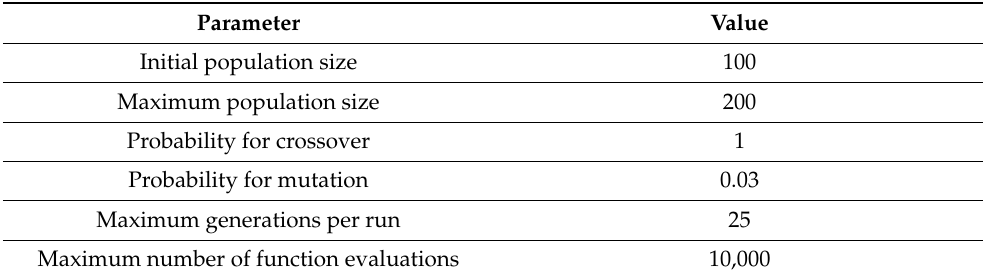
Table 3. MOGA parameters used for the LIDs